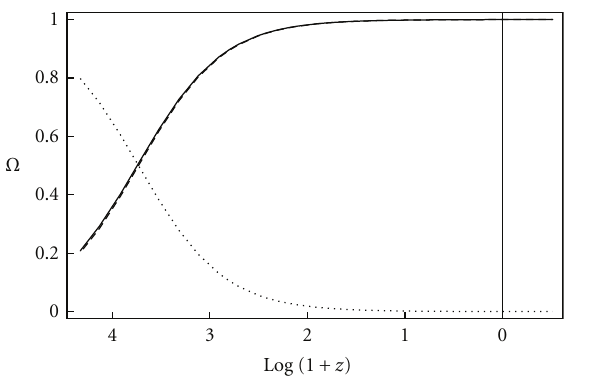
Figure 4: Redshift evolution of the scalar field of the scalar field variables X = ˙ ϕ 2 / 2 (top) and ϕ (bottom); see